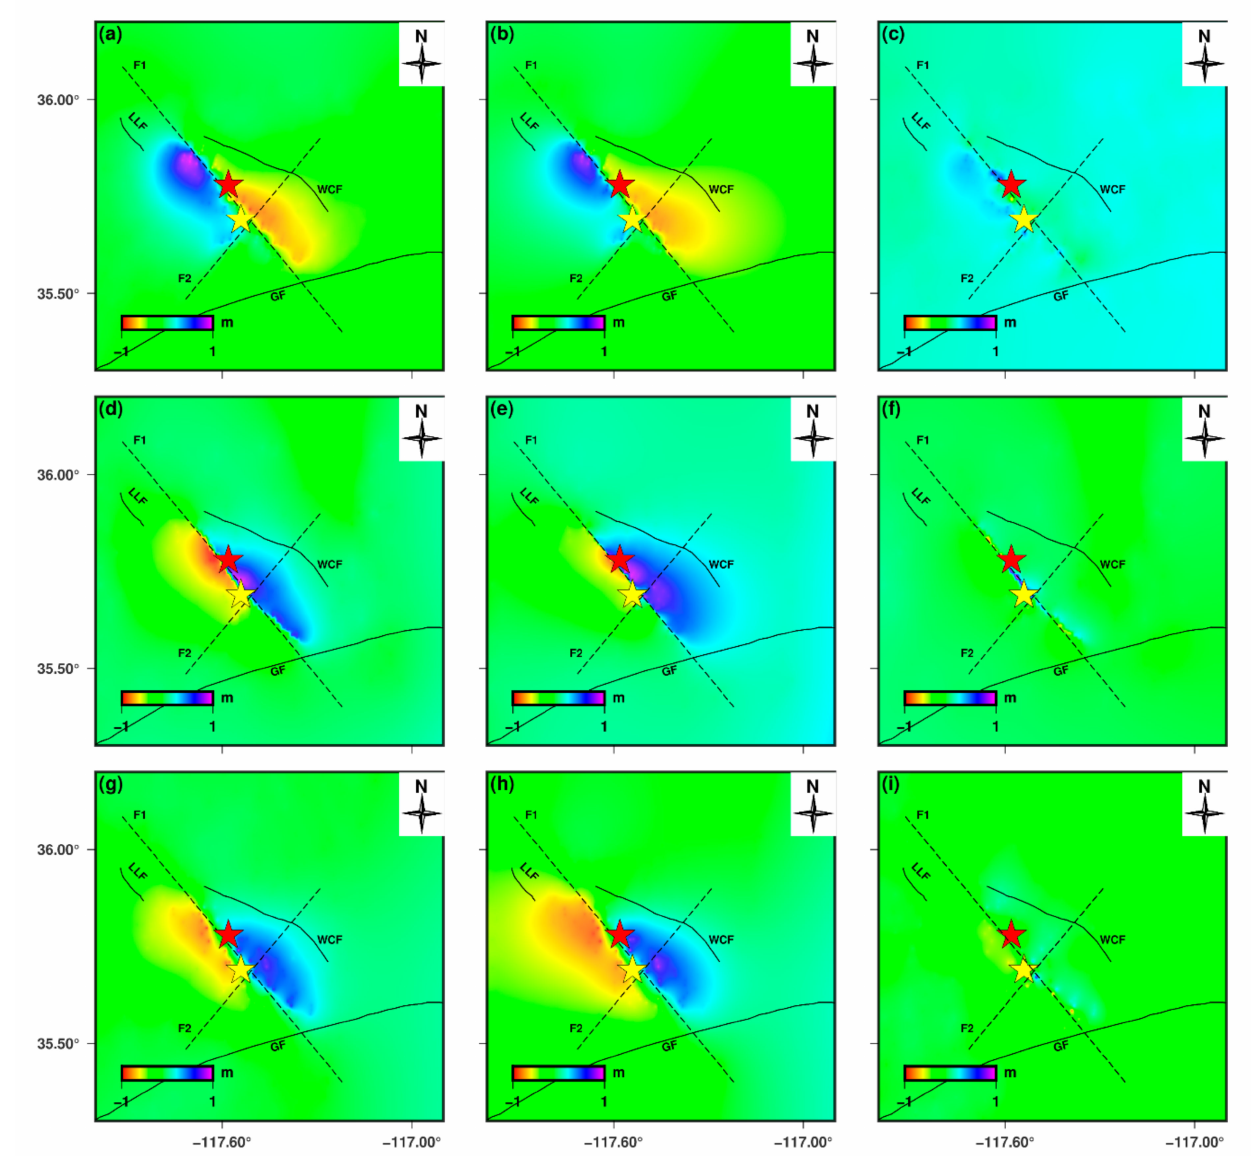
Figure 8. Comparison between co-seismic deformation observations and distributed slip model of 2019 California earth- quake. Red and yellow stars are mainshock and foreshock, respectively. ( a ) Observation, ( b ) prediction, and ( c ) residual from Sentinel-1A (T064A). ( d ) Observation, ( e ) prediction, and ( f ) residual from Sentinel-1A (T071D). ( g ) Observation, ( h ) prediction, and ( i ) residual from ALOS-2